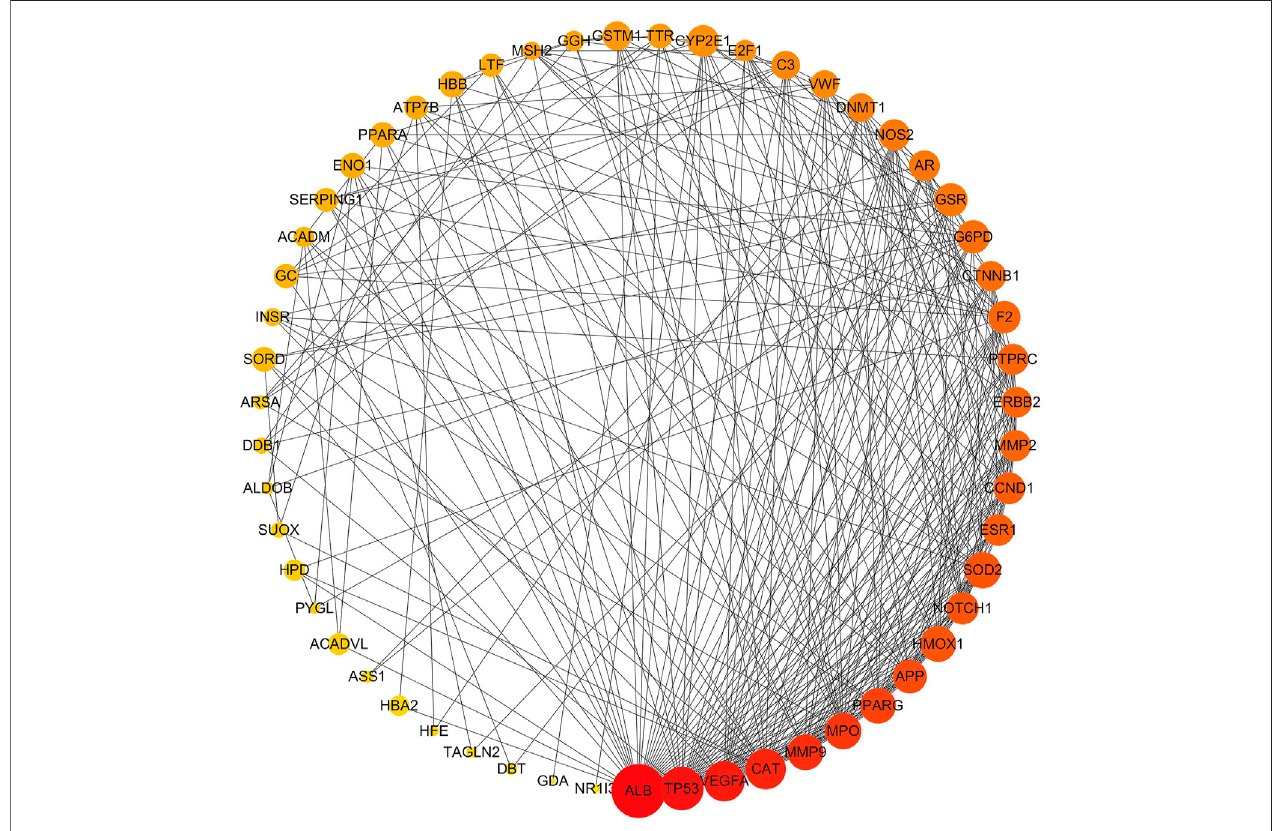
FIGURE 1 | Hepatic toxicity targets protein – protein interaction network. Nodes are hepatotoxic targets; edges are target protein interactions.